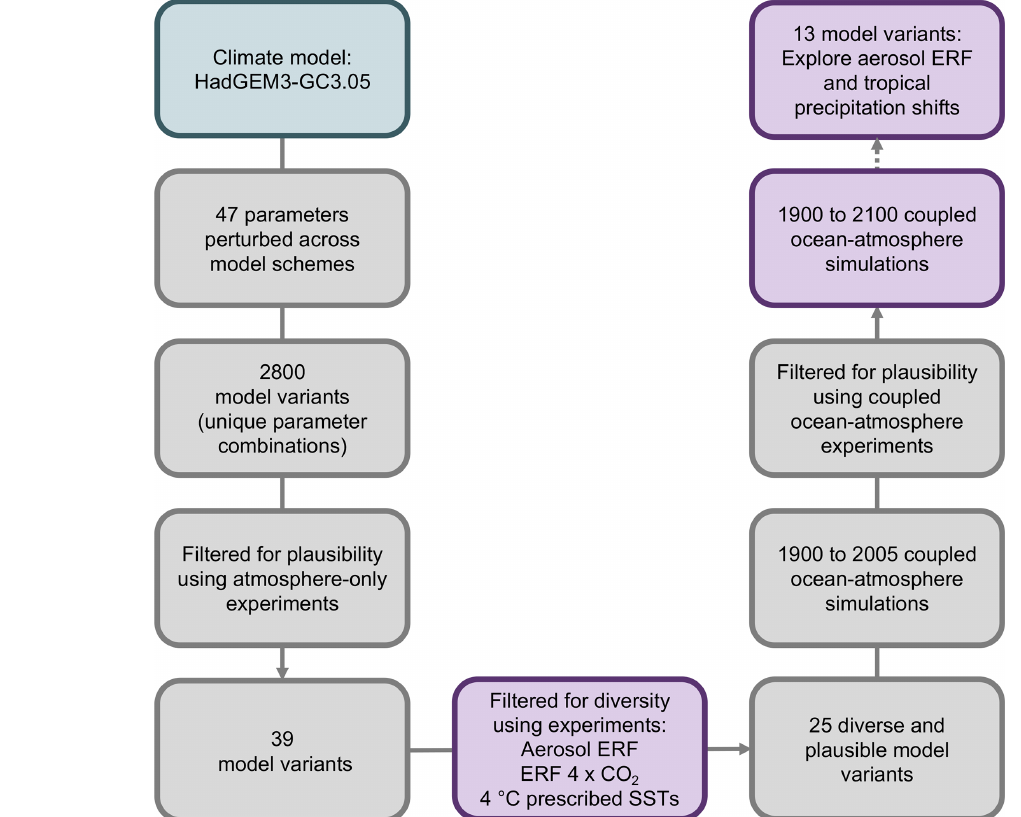
Figure 2. Schematic showing the stages in the design process used in UKCP18 to provide a small subset of model variants that sample a diverse climate response and are plausible when evaluated against historical climate. In this study, we use 13 PPE members of the aerosol ERF and transient coupled ocean–atmosphere experiments which are highlighted in the purple